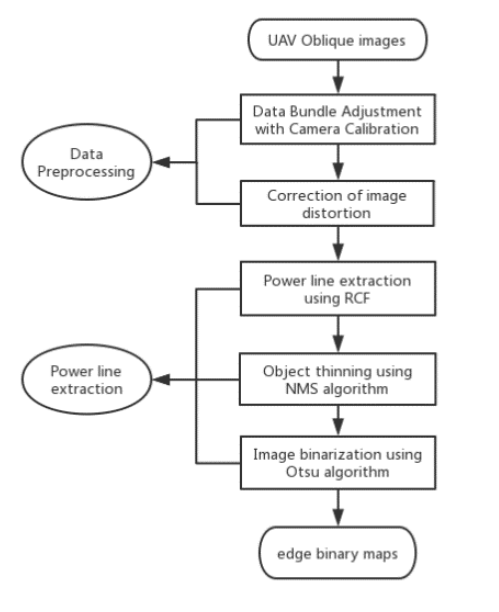
Figure 1. Workflow of Power lines extraction procedure